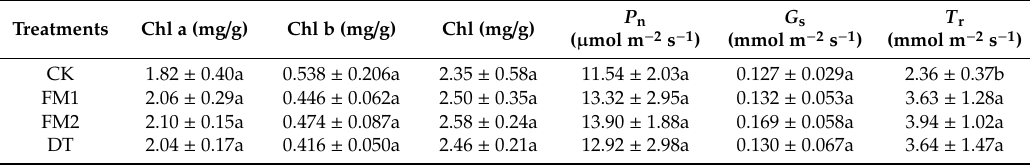
Table 2. E ff ects of arbuscular mycorrhizal fungi on photosynthetic pigments and photosynthesis of G. sinensis